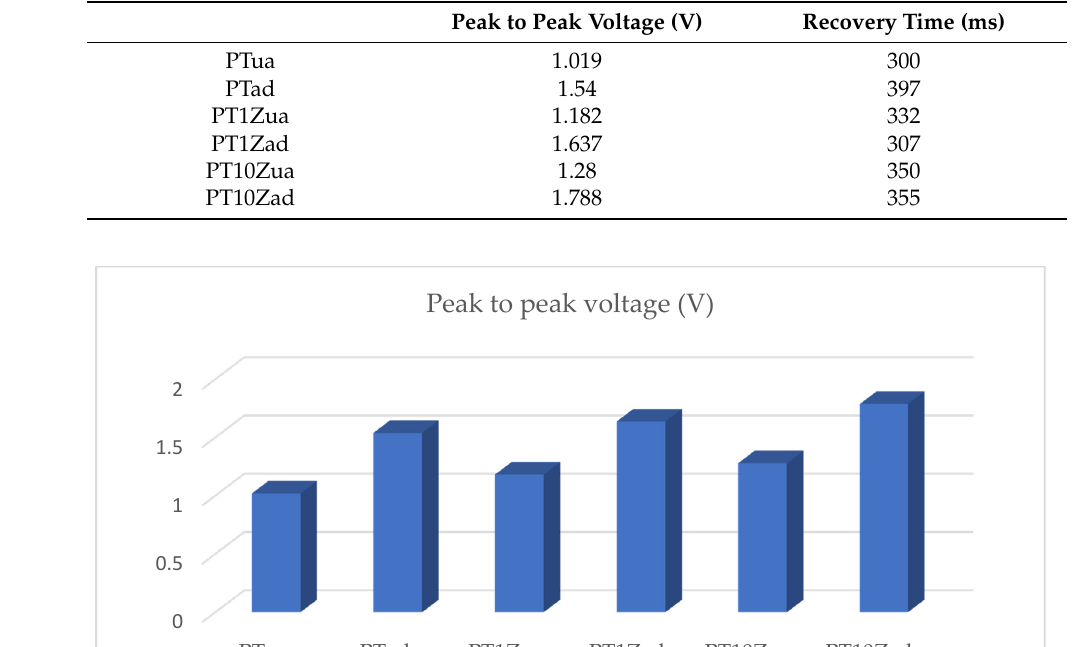
Figure 9. The human pulse waveform captured by sample PT10Zad. 4. Conclusions In this paper, novel piezoelectric PVDF-TrFE and PVDF-TrFE-ZnO membranes were fabricated by electrospinning, characterized and investigated. To test the piezoelectric re- sponse of the fabricated membranes, the pressure sensors in a simple sandwich structure